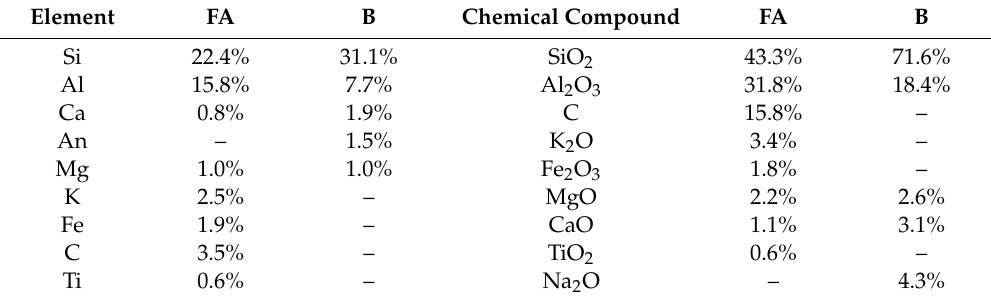
Figure 4. SEM images of fly ash-bentonite mixture—magnification of 2400×. Table 1. Chemical composition of bentonite (B) and fly ash (FA).